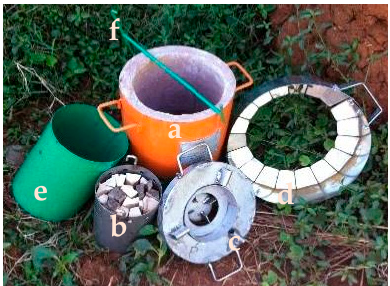
Figure 1. GASTOV. The “GASTOV” gasifier stove has the following parts: ( a ) an insulated casing with a 5.5 cm × 4.5 cm air inlet with a door (damper) that can be regulated at half or full height at the bottom, ( b ) a 19 cm high fuel canister in the middle, ( c ) a 6 cm high gas combustion chamber on top as the main burner, fitted with a skirting ( d ) to hold the pot in position and protect flames from wind, ( e ) a charcoal cover (snuffer) used to cool the charcoal by cutting off oxygen, and ( f ) a canister holder.